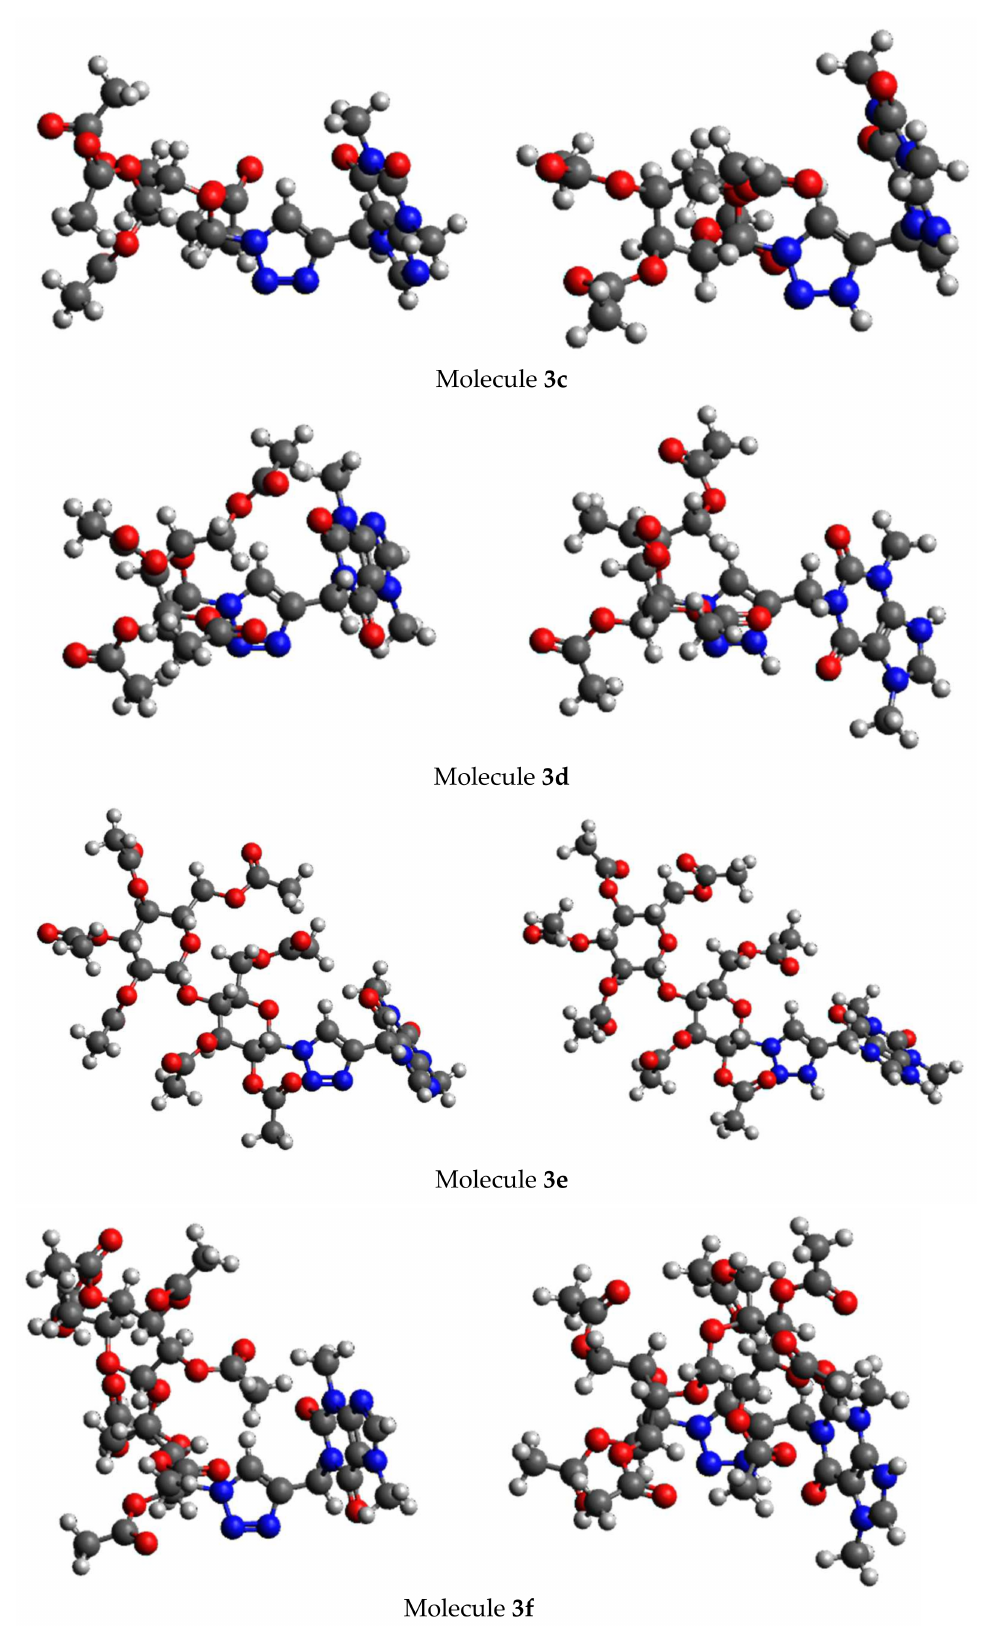
Figure 12. Optimized unprotonated and protonated inhibitor molecules considered in the present study. Gray corresponds to carbon, blue to nitrogen, red to oxygen, and white to